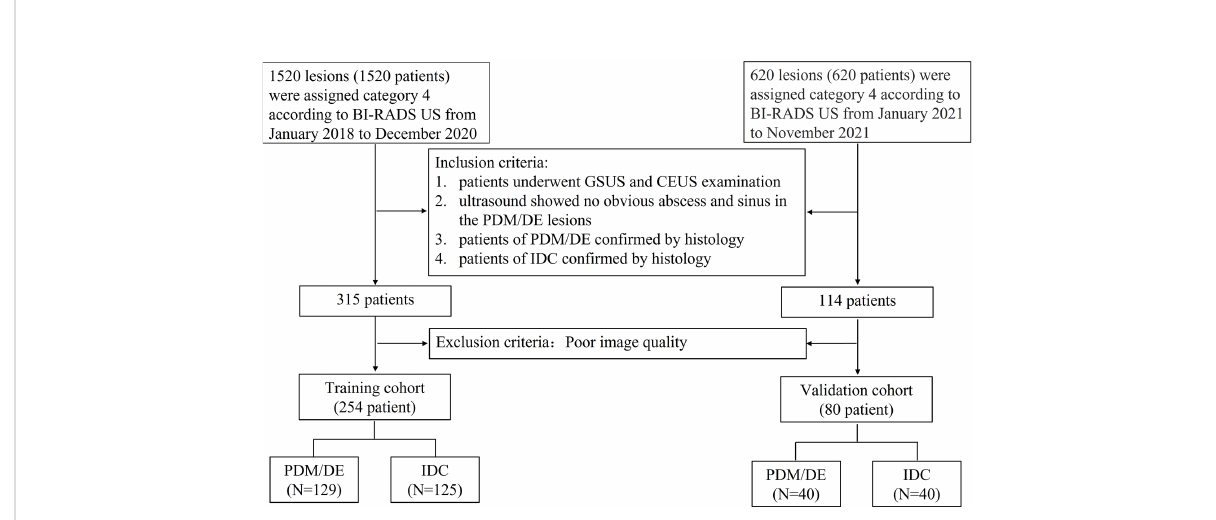
FIGURE 1 The fl owchart of inclusion and exclusion of the study subjects. BI-RADS US Breast Imaging Reporting and Data System Ultrasound; GSUS gray scale ultrasound; CEUS contrast enhanced ultrasound; PDM/DE periductal mastitis/duct ectasia; IDC invasive ductal